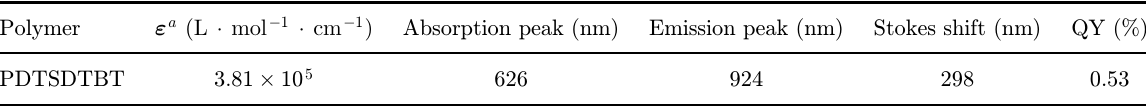
Table 1. Optical properties of PDTSDTBT.